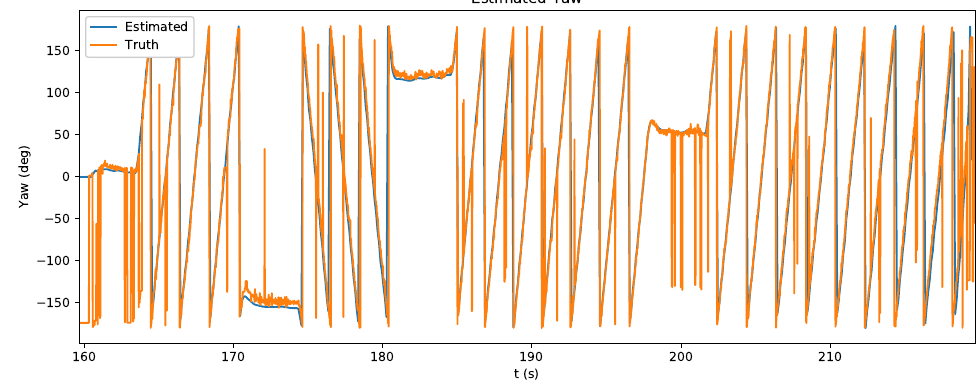
Figure 14. Yaw estimation during experiment. Pose was estimated using the stock Crazyflie EKF algorithm, which relies on gyroscope measurement data.